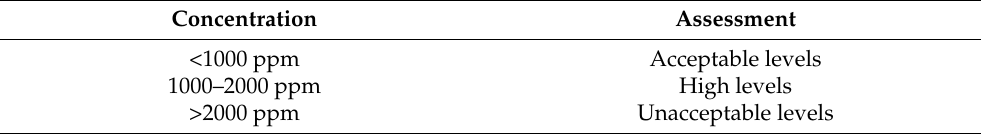
Table 1. Concentration levels of CO 2 and their assessment.